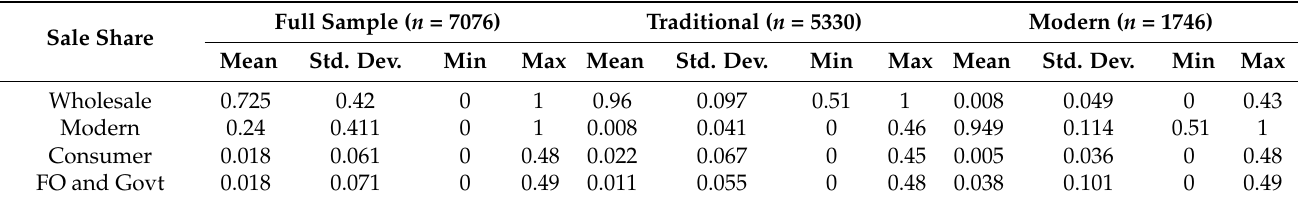
Table 5. Share of each income source in total sales to food